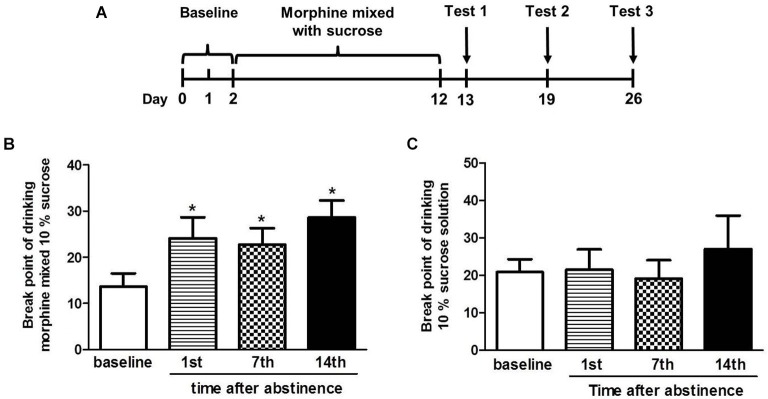
The break point of drinking morphine mixed with 10% sucrose solution or 10% sucrose solution after the abstinence. (A) Diagram outlining the behavioral procedures. (B) The break point of drinking morphine mixed with sucrose in the tree shrews was significantly increased when compared to the baseline on the 1st, 7th and 14th day after the abstinence. (C) The break point of drinking 10% sucrose in the tree shrews was not changed vs. the baseline at any of the three time point. The data are expressed as means ± SEM, n = 4. * p < 0.05, compare to the baseline, t-test.